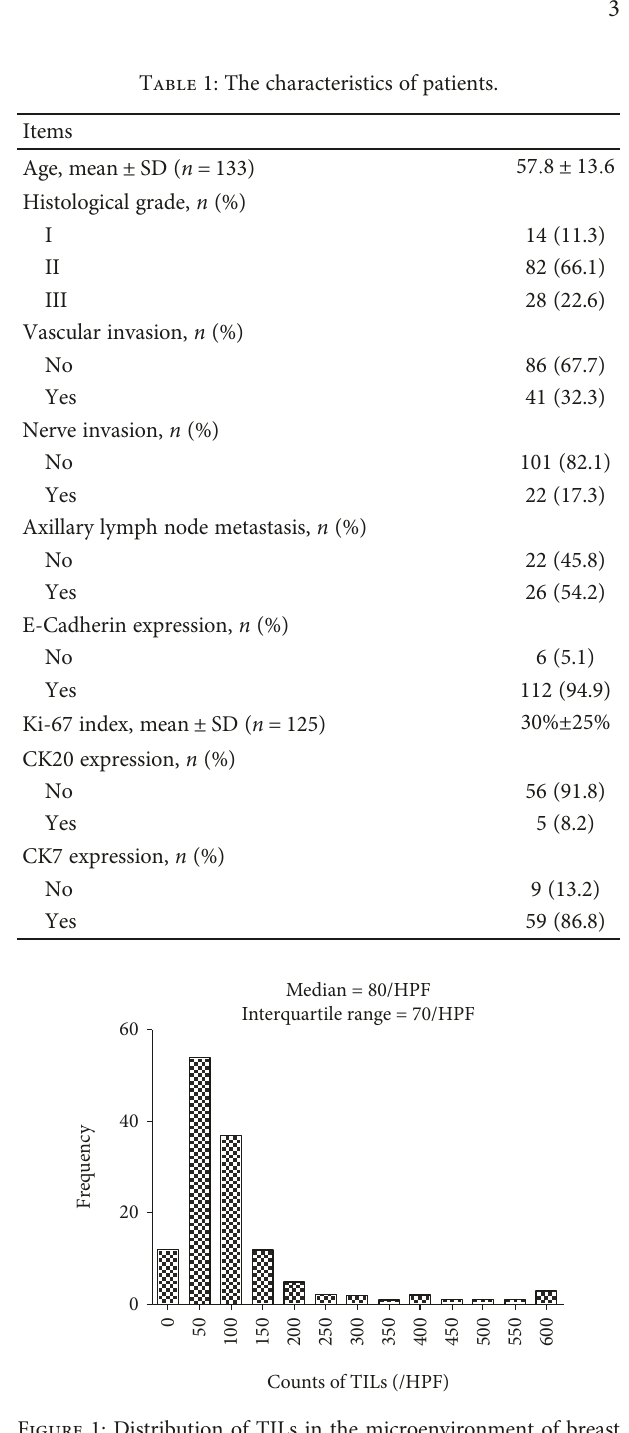
Figure 1: Distribution of TILs in the microenvironment of breast